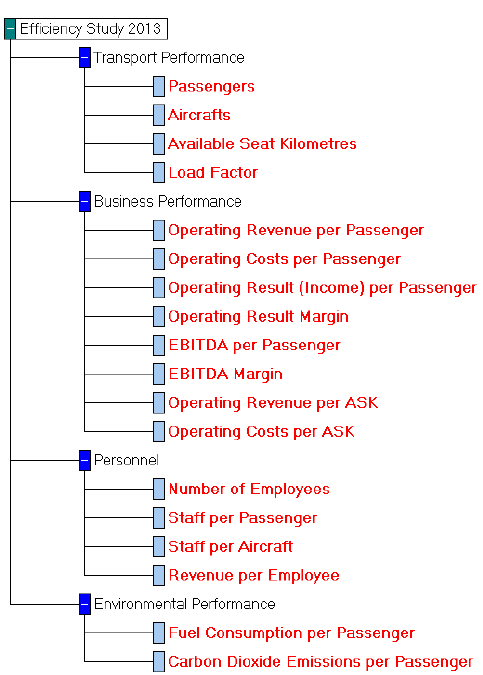
Figure 1: Main drivers of cost differences between LCCs and LCs [3].